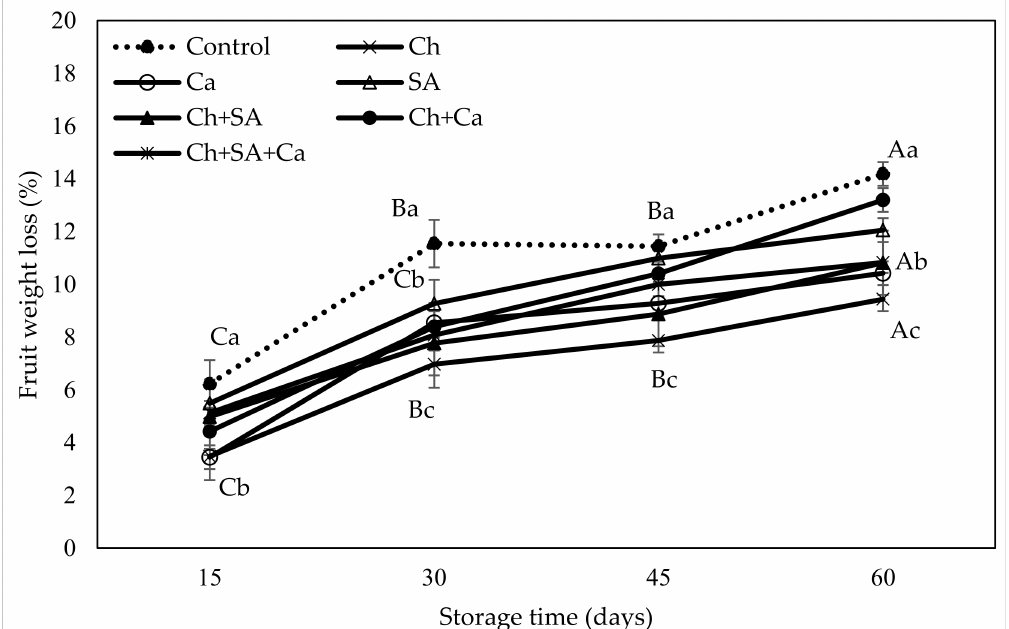
Figure 1. Effect of preharvest application of natural elicitors on weight loss percentage of “Barhi” fruit during cold storage for two months; values are the mean (n = 25) ± SE. The LSD test at p ≤ 0.05 was used to compare the means between treatments. Means with the same letter(s) between treatments within storage time intervals (small letter) and at different time intervals (capital letter) are not significantly different. Ch: chitosan; SA: salicylic acid; Ca: calcium